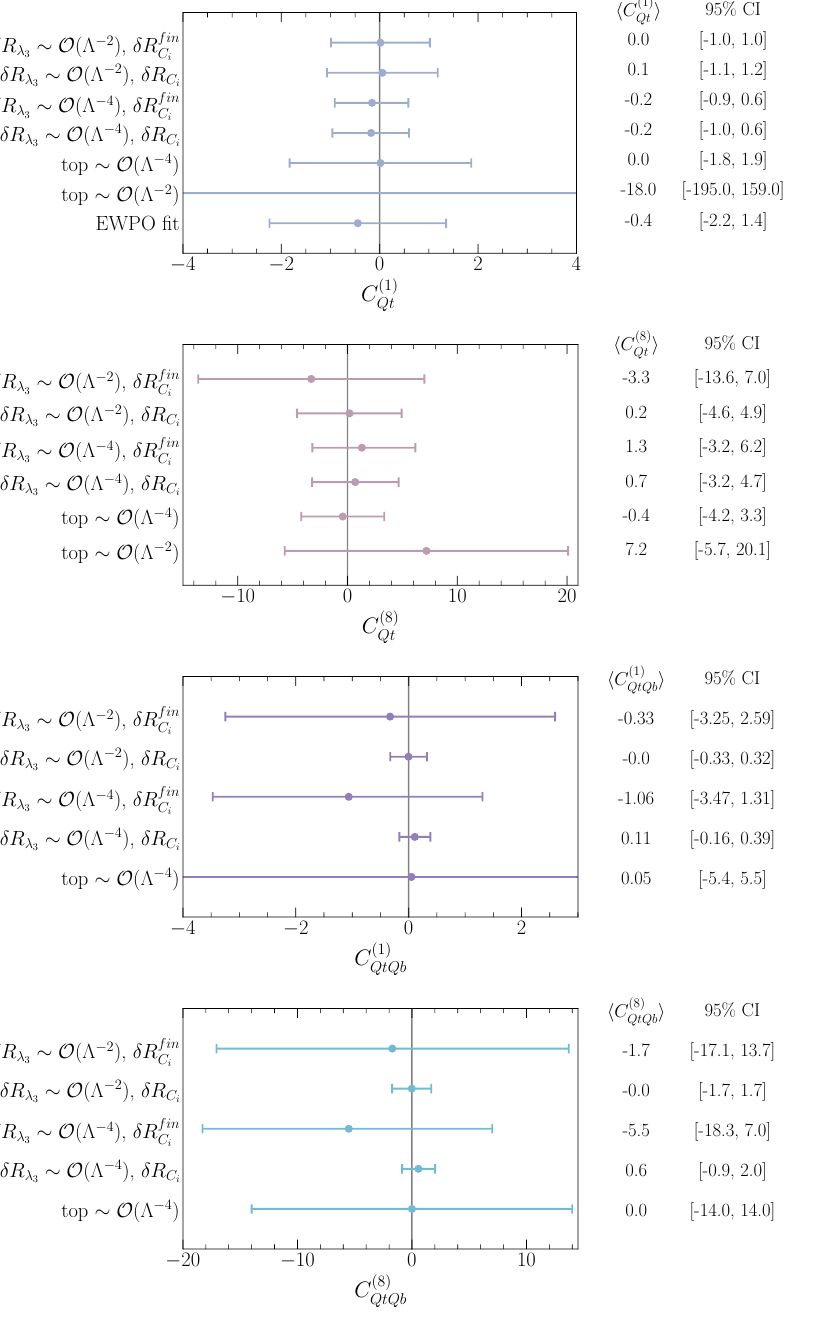
Figure 5 . Forest plots illustrating the means and 95% CIs of the posteriors built from the four- fermion Wilson coefficients with C φ marginalised. The plots confront also the truncation of the EFT at O (1 / Λ 2 ) and O (1 / Λ 4 ) of δR λ , as defined in eq. (4.4). The 95% CI bounds stem from Higgs 3 data. The last two rows for each operator show instead the limits obtained by a single parameter fit to top data, linear and quadratic. For the case of C (1) , we also compare with the results from Qt the single-parameter fit using electroweak precision observables (EWPO) from [13]. The top data results are taken from [55] for C (1) , (8) and [6] for C (1) , (8) Qt QtQb